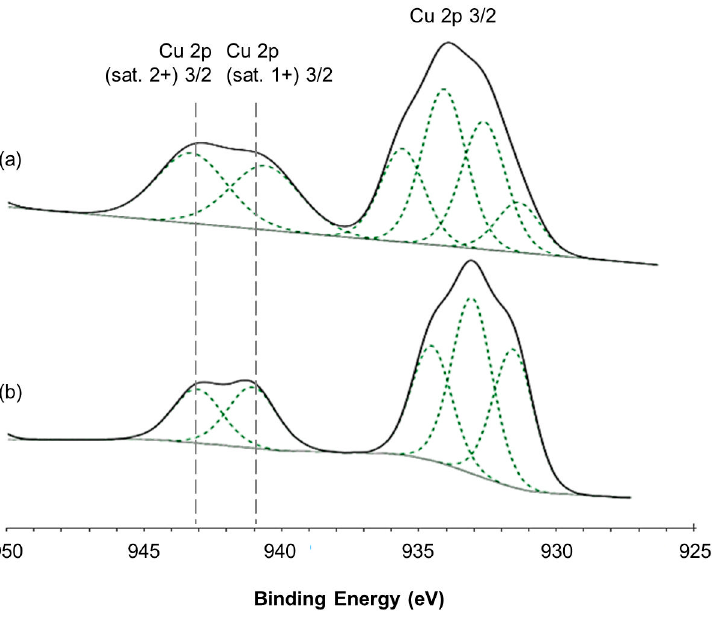
Figure 4. Cu 2p 3/2 XPS spectra with peak fittings of ( a ) Cu-Zn (no magnet)/CeO 2 -Al 2 O 3 (no magnet) and ( b ) Cu-Zn (N-S)/CeO 2 -Al 2 O 3